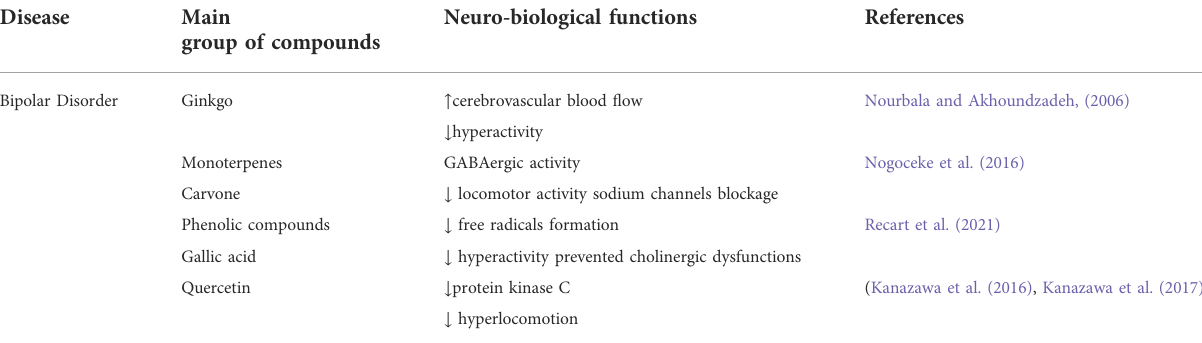
TABLE 4 Bioactive compounds and their major effects in the treatment of bipolar disorders.